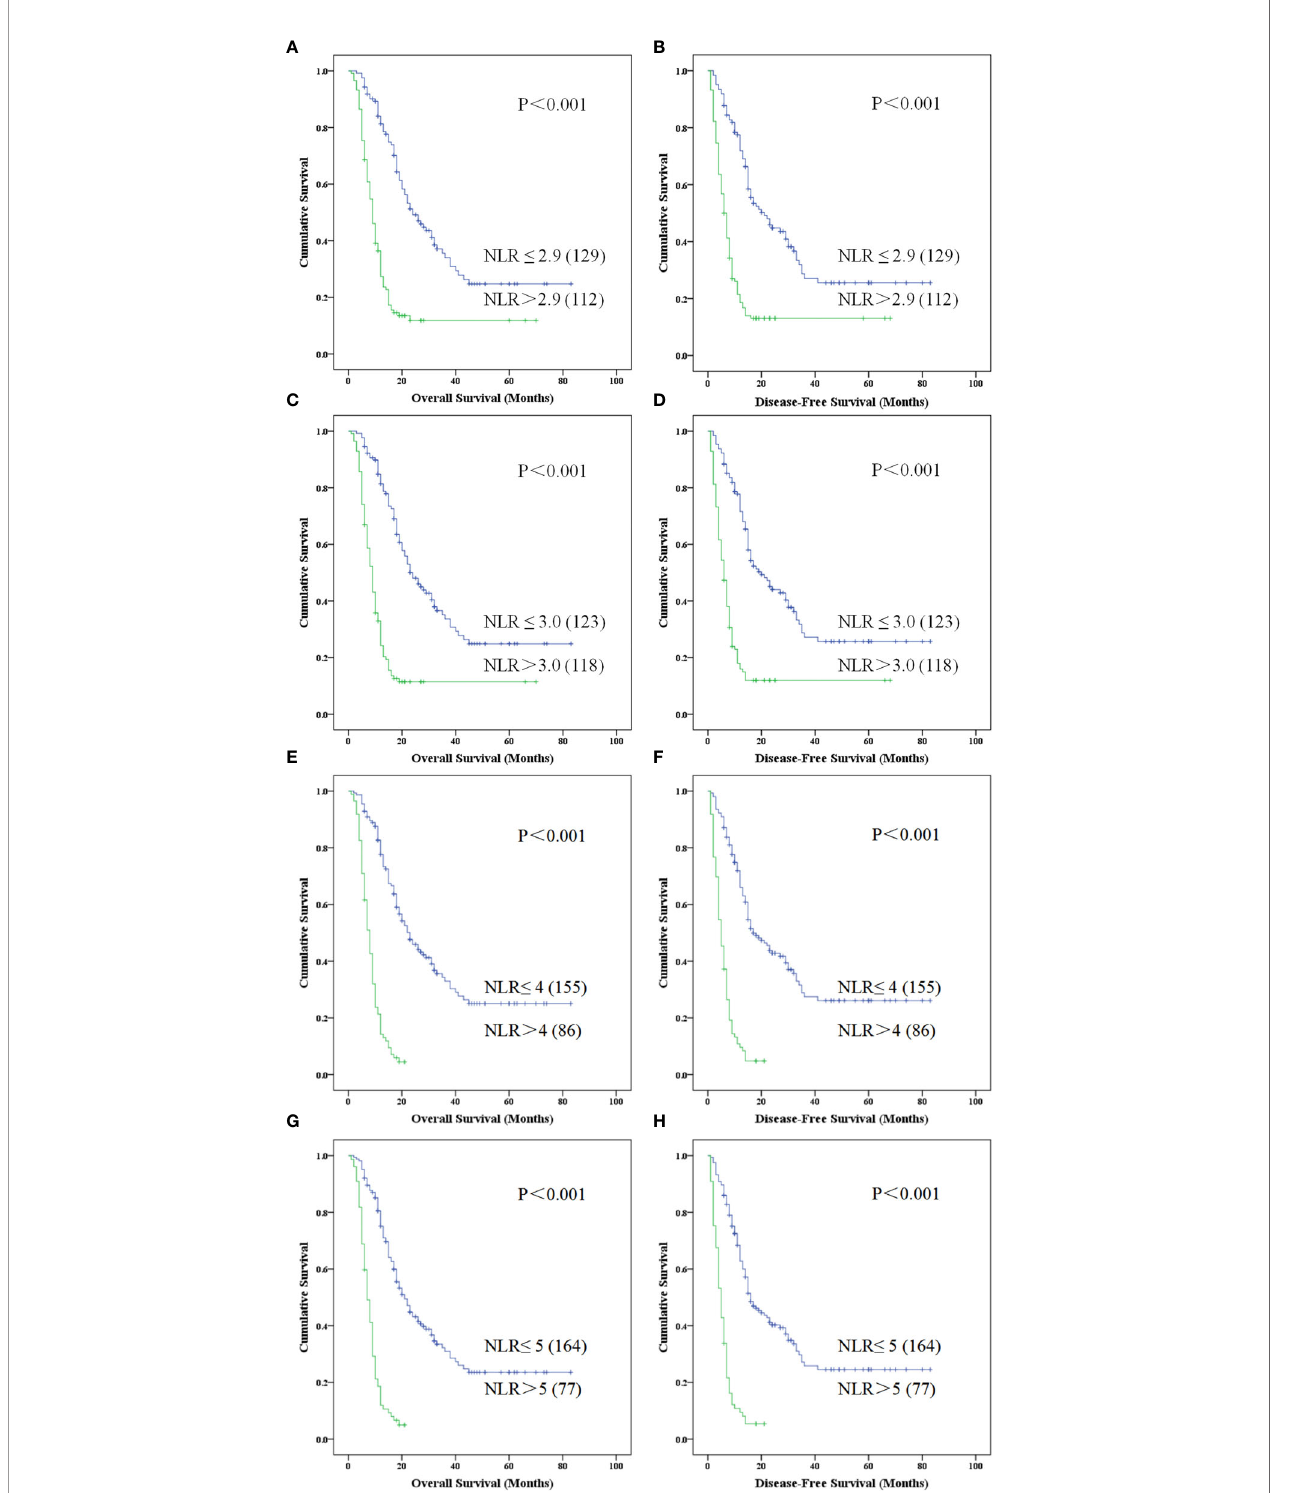
FIGURE 4 | Kaplan-Meier curve for overall survival and disease free survival of patients with advanced PDCA by high NLR vs . low NLR for different NLR divided standards. (A – H) represented patients with higher NLR is associated with poorer survival which was obviously in NLR > 5 (P < 0.001) (NLR, neutrophil-to- lymphocyte ratio; PDAC, pancreatic ductal